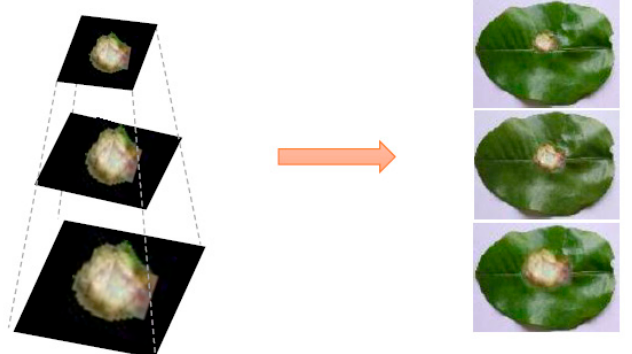
Figure 7. Extension of the sample dataset using image pyramids. We used image pyramids to change the size of the lesion image and synthesize it with the leaves. It greatly expanded the number of diseased leaf samples.